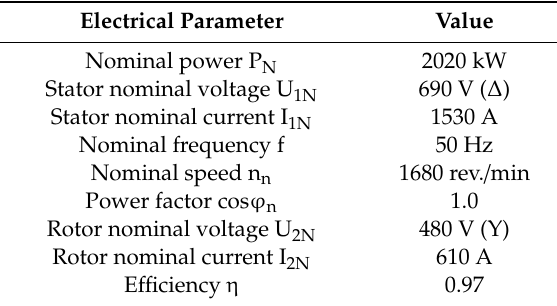
Table 2. Basic parameters of asynchronous generator.